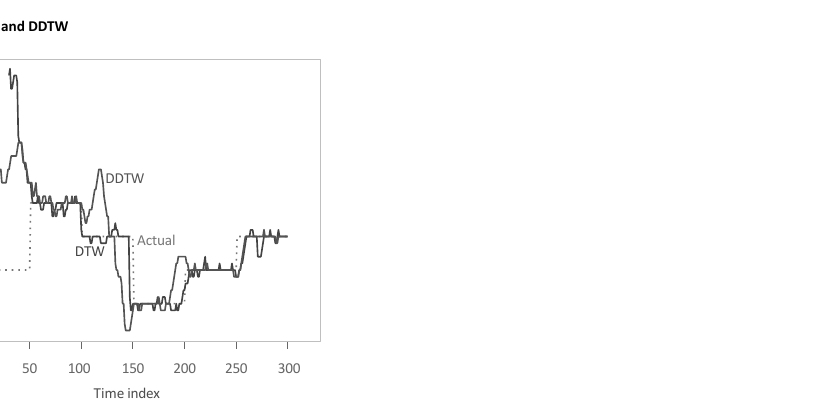
Figure 9. Time-dependent lag structure estimate through Dynamic Time Warping (DTW) and Derivative DTW